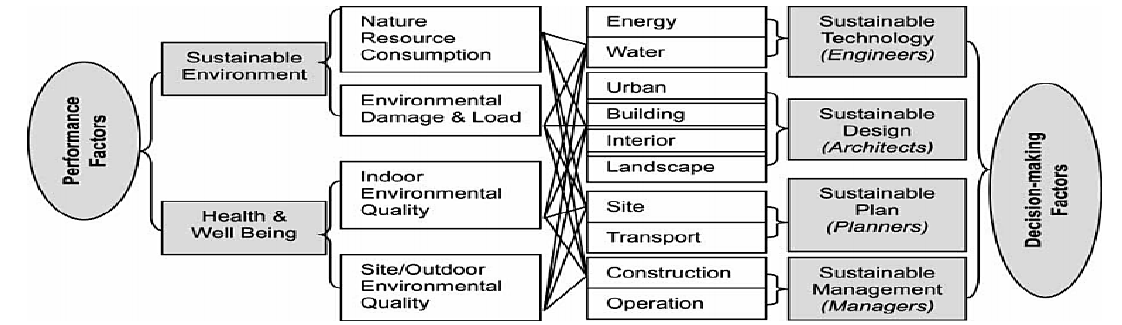
Fig. 2. All the performance factors that are most important in decision making for sustainable design (Osmani et al., 2018)